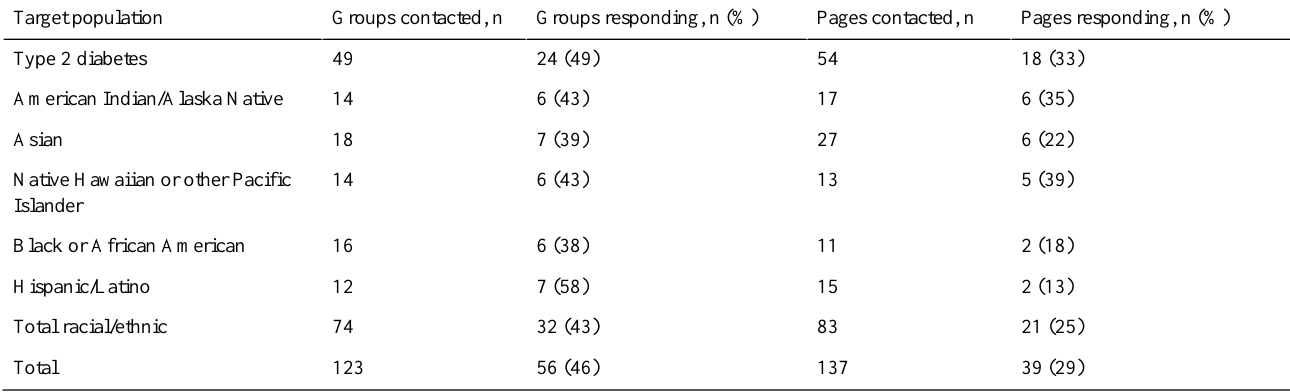
Table 1. Study 2 group and page